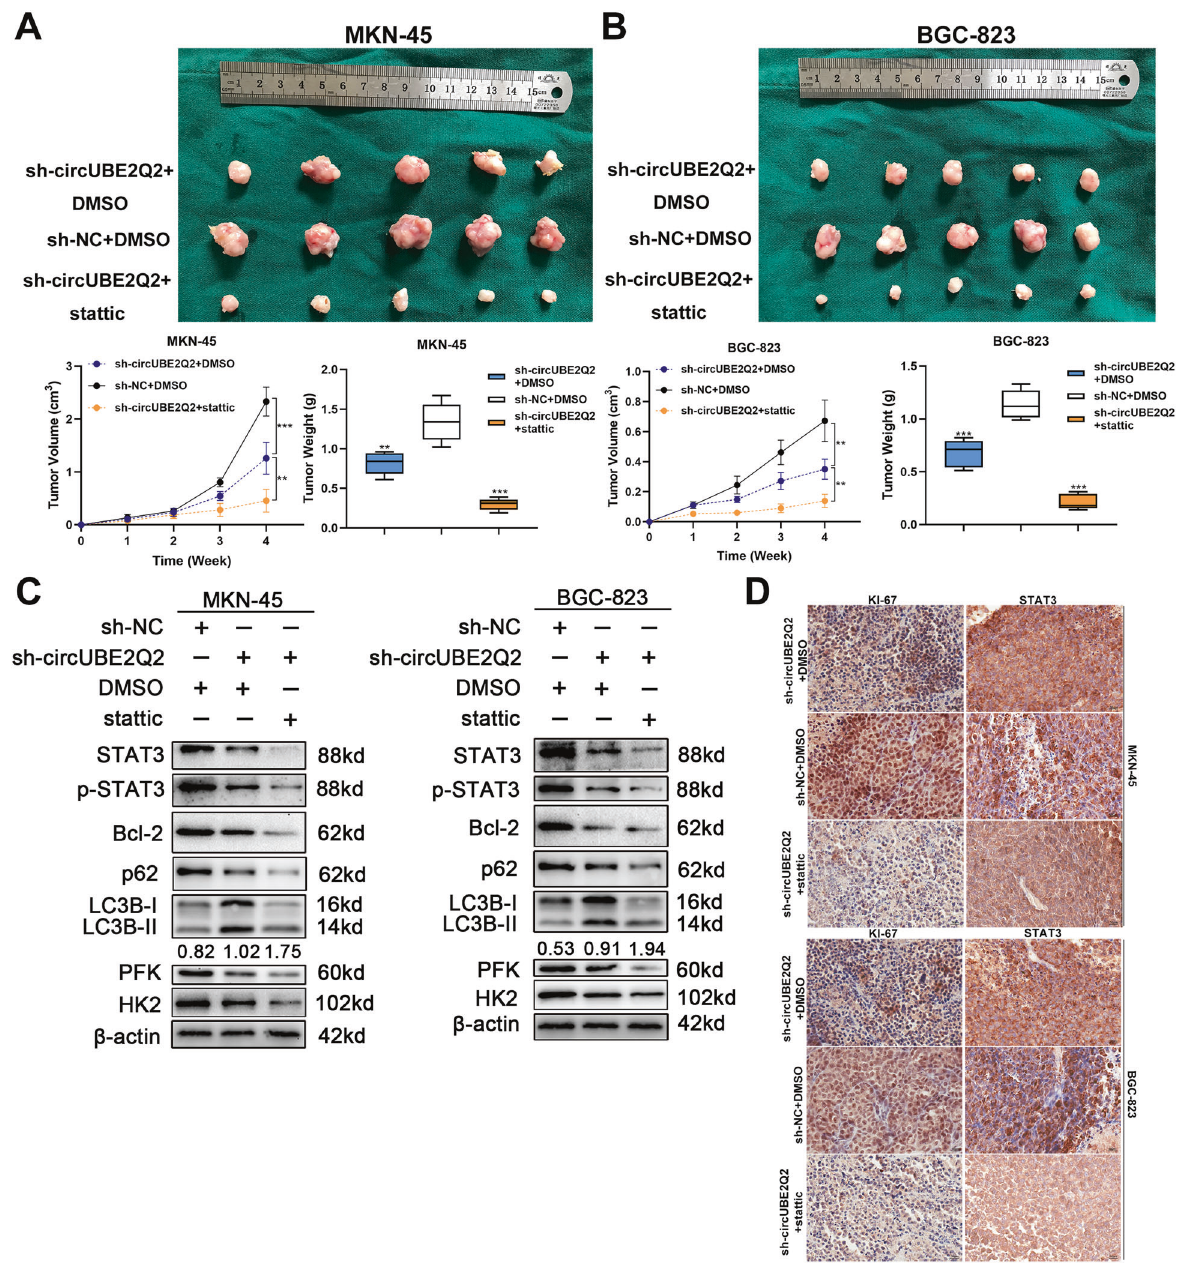
Fig. 8 Combination of circUBE2Q2 knockdown and stattic has a stronger tumor suppressor role. A , B Tumor volume and weight in mice that received subcutaneous injections. C Protein levels of STAT3, p-STAT3, Bcl-2, p62, LC3B, PFK, and HK2 in xenograft tumor tissues detected by western blottings. D Immunohistochemistry staining (IHC) of STAT3 and Ki-67 in respective xenograft tumor tissues. Data are expressed as the mean ± SD. * p < 0.05, ** p < 0.01, *** p <